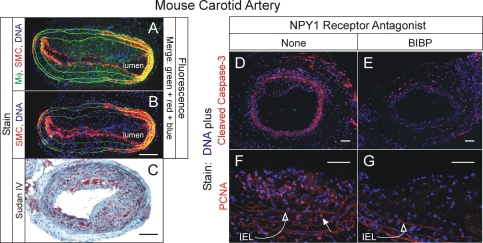
Mouse carotid atherogenesis: cellular effects of a NPY Y1 receptor antagonist.Immediately after wire-mediated endothelial denudation, carotid arteries of apoe
−/− mice were encased in Pluronic gel lacking (“None,” “control”) or containing the NPY1 receptor-selective antagonist BIBP 3226 (“BIBP”). Carotid arteries were harvested 6 wk (A–C) or 2 wk (D–G) postoperatively, and processed as described in Methods. A, B, Typical atherosclerosis in a representative control-treated carotid artery. Frozen sections were stained for DNA and (immunofluorescently) with IgG specific for SMC α-actin and either the macrophage marker Mac3 (A), or an isotype negative control rat IgG (B). Green autofluorescence of the elastic laminae can be seen in both A and B. Alternatively, frozen sections were stained for cholesteryl ester with Sudan IV and hematoxylin counterstain (C). Scale bar = 100 µm. D, E, Carotid sections were stained with IgG for cleaved caspase-3 (apoptosis marker) and counterstained for DNA; specimens stained with non-immune rabbit IgG yielded no red immunofluorescence (not shown). Scale bar = 50 µm. F, G, Carotid sections were stained with IgG for proliferating cell nuclear antigen (PCNA), counterstained for DNA, and oriented with the lumen side upward. The closed arrow designates a single PCNA-positive nucleus in the tunica media, representative of >20 such nuclei in the field shown; specimens stained with non-immune rabbit IgG (not shown) yielded only elastic lamina autofluorescence, like that observed in panels F and G. IEL, internal elastic lamina, indicated by the open arrows. Scale bar = 50 µm. All images are representative of ≥4 independent specimens stained with each modality.